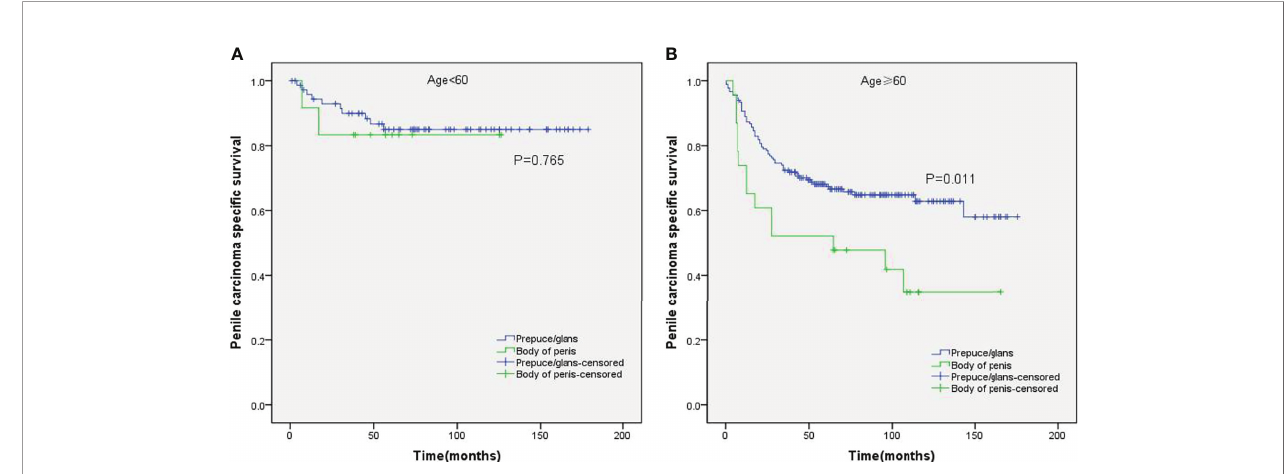
FIGURE 2 | Kaplan – Meier analyses of penile carcinoma-speci fi c survival in age < 60 years group (A) and age ≥ 60 years group (B) in patients strati fi ed by tumor